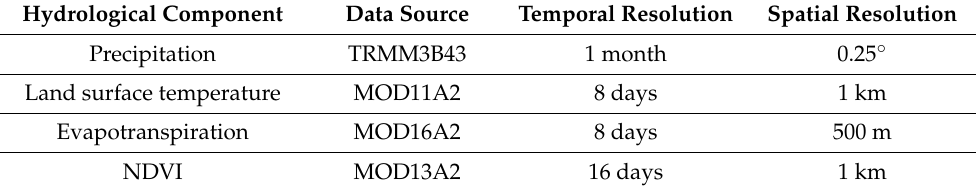
Table 1. Remotely sensed data products used in this